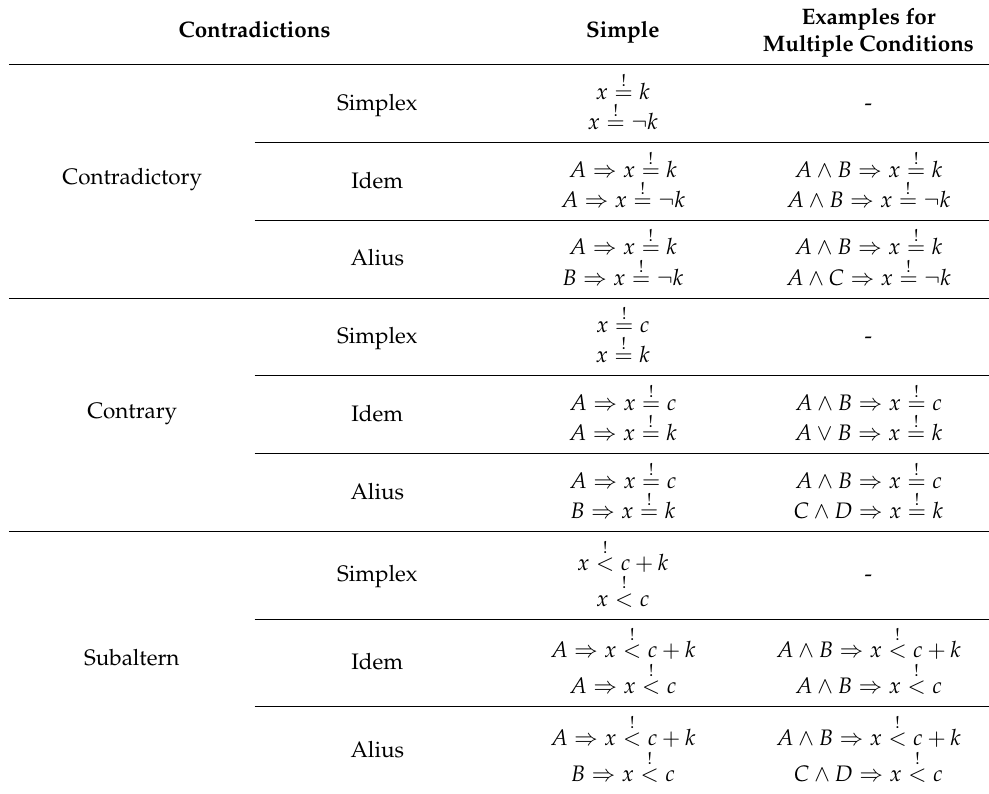
Table 1. Formalized